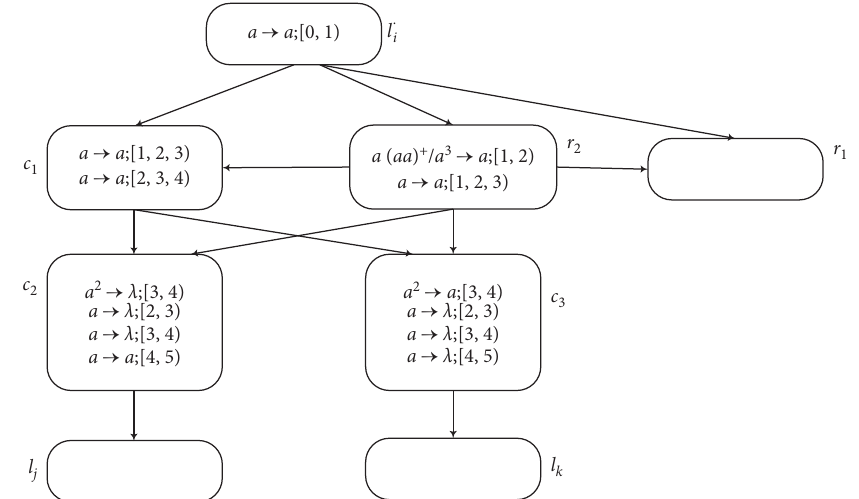
Figure 13: Module ADD-SUB: simulating the sequence of ADD instruction l